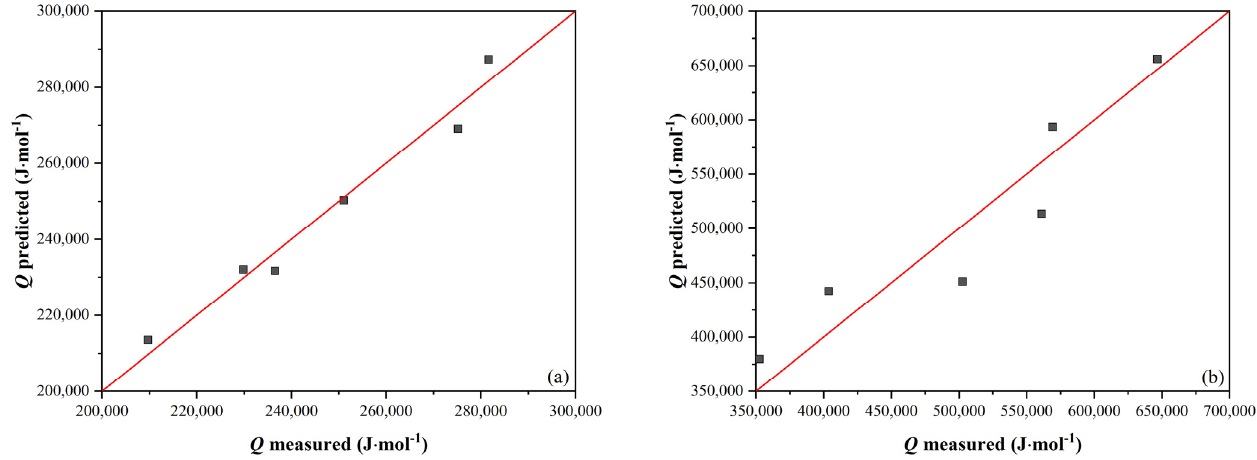
Figure 5. Dependence of Q on the strain and Nb content (without SIP): ( a ) without SIP and ( b ) with SIP.